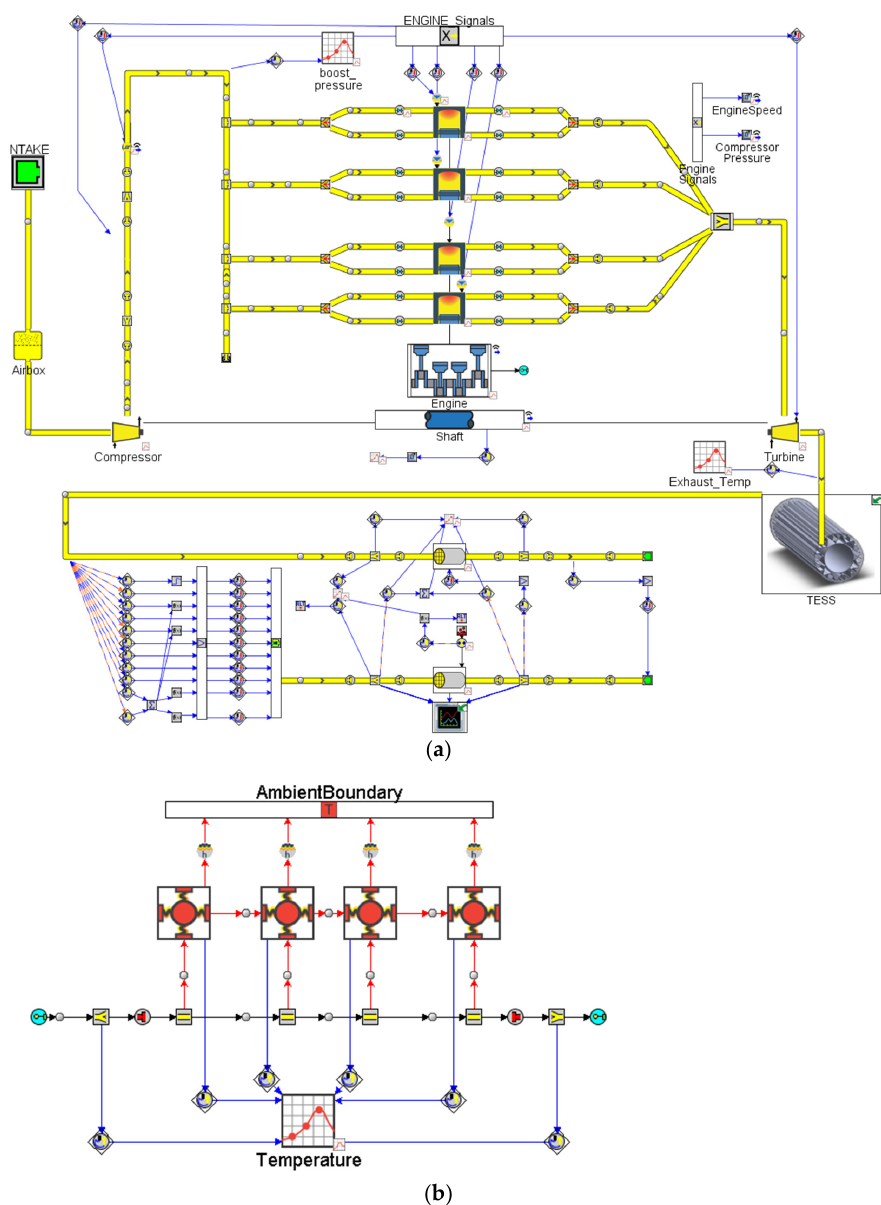
Figure 5. ( a ) Overall layout of the Engine + TESS + TWC ( b ) Detailed view of principal connection of PCM material with body of the exchanger in TESS. PCM material with body of the exchanger in